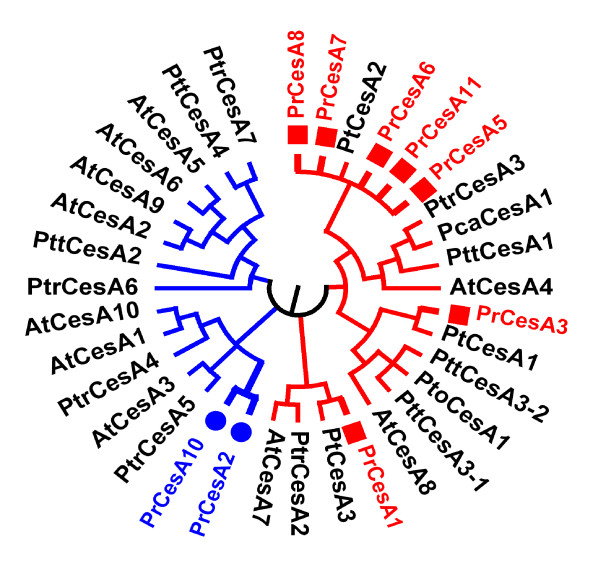
Phylogenetic tree of CesA proteins from radiata pine and other species. Muscle software was used to align multiple protein sequences of CesAs derived from GenBank. The protein sequences are deduced amino acid sequences from full length cDNAs except for some radiata pine CesAs. GenBank accession numbers are as follows: Pinus radiata, PrCesA1 (AAT57672), PrCesA2 (AAQ63936), PrCesA3 (AAQ63930), PrCesA5 (AAQ63931), PrCesA6 (AAQ63932), PrCesA7 (AAQ63933), PrCesA8 (AAQ63934), PrCesA10 (AAQ63935), PrCesA11 (AAQ63929). PrCesA1 and PrCesA10 are full length sequences, PrCesA2 is nearly full length sequence, others are partial sequences; Pinus taeda, PtCesA1 (AAX18647), PtCesA2 (AAX18648), PtCesA3 (AAX18649); Populus tremuloides, PtrCesA2 (AAM26299), PtrCesA3 (AAQ08987), PtrCesA4 (AAO25536), PtrCesA5 (AAL23710), PtrCesA6 (AAP40636), PtrCesA7 (AAO25581); Populus tremula × Populus tremuloides, PttCesA1 (AAT09894), PttCesA2 (AAT09895), PttCesA3-1 (AAT09896), PttCesA3-2 (AAT09897); Populus tomentosa, PtoCesA1 (AAY21910); Populus canescens, PcaCesA1 (AAC78476); Arabidopsis thaliana, AtCesA1 (O48946), AtCesA2 (O48947), AtCesA3 (Q941L0), AtCesA4 (Q84JA6), AtCesA5 (Q8L778), AtCesA6 (Q94JQ6), AtCesA7 (Q9SWW6), AtCesA8 (Q8LPK5), AtCesA9 (Q9SJ22), AtCesA10 (Q9SKJ5). Red colour indicates secondary cell wall CesAs, blue colour indicates primary cell wall CesAs.